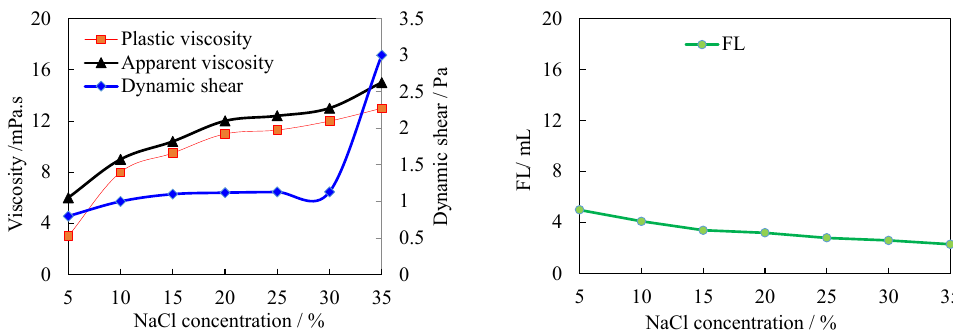
Figure 7. Salt resistance test results of modified starch.